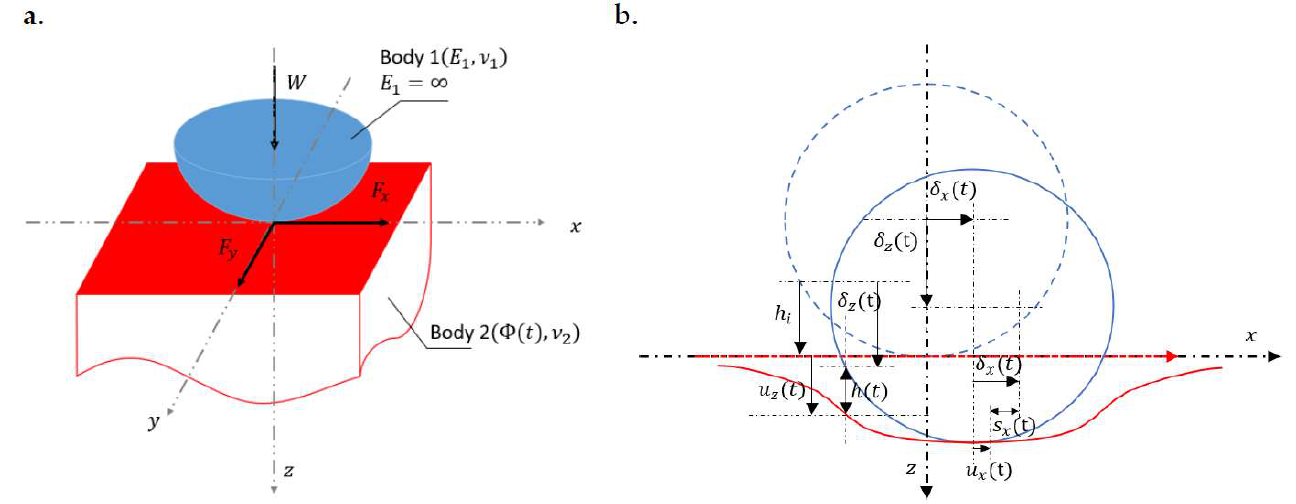
Figure 2. ( a ) Geometry of the contacting bodies: W , F x , F y are the input normal load and the tangential loads in x and y directions, respectively, E 1 ( E 1 = ∞ ) and ν 1 are the elastic modulus and Poisson’s ratio of the rigid sphere, respectively, and Φ ( t ) and ν 2 are the time-dependent creep compliance and Poisson’s ratio of the viscoelastic half-space, and ( b ) Transient displacement condition on the x − z plane: h i denotes the gap between surfaces before loading, h ( t ) , s x ( t ) , δ ( t ) , u ( t ) are the gap between deformed surfaces, the slip distance in the x direction, the rigid body displacement, and the surface deformation after a certain time 𝑡 , respectively, with subscript denot- ing the direction of relevant vectors.